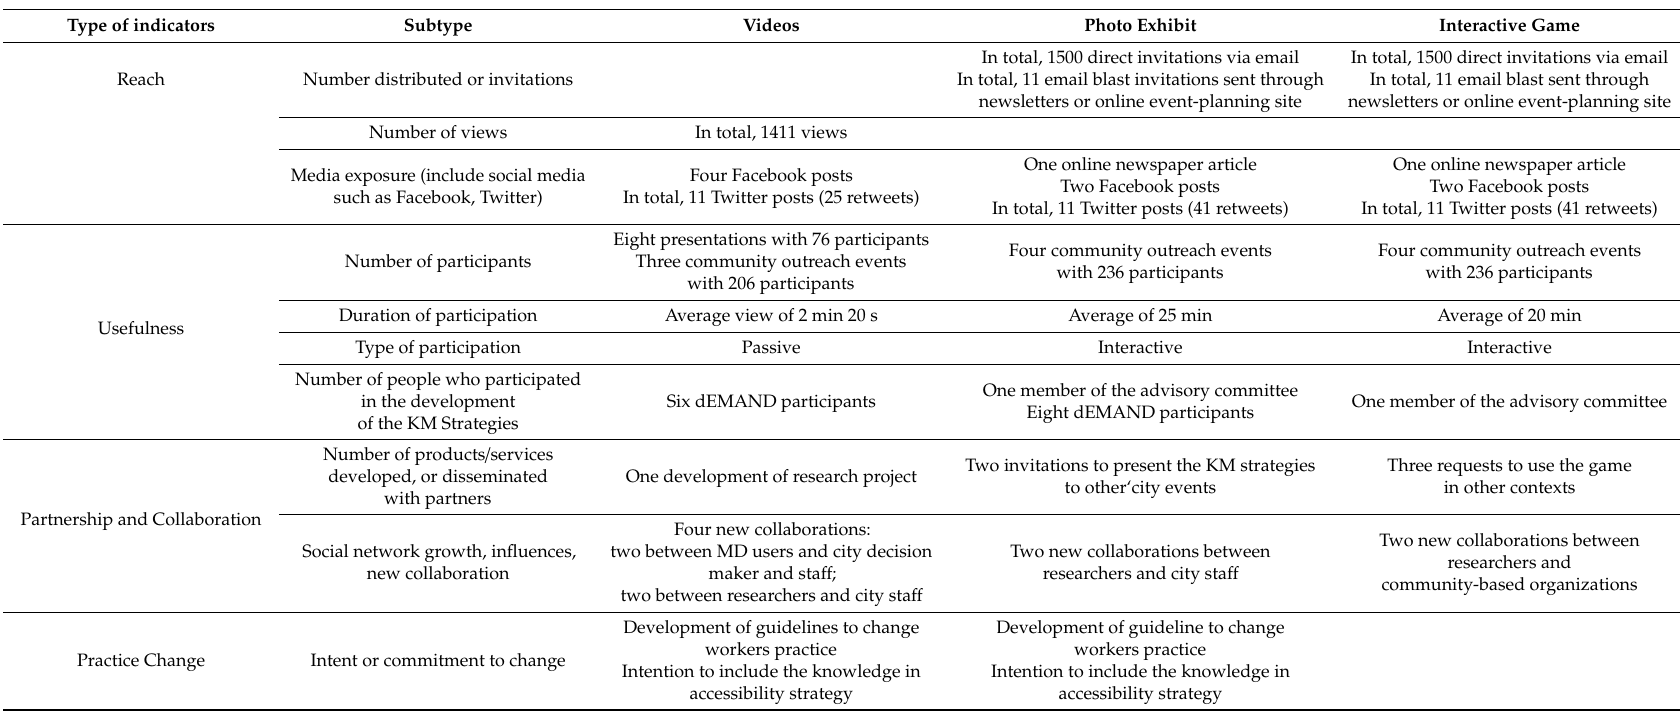
Table 2. Impact Indicators from the Journal and Observations by KM